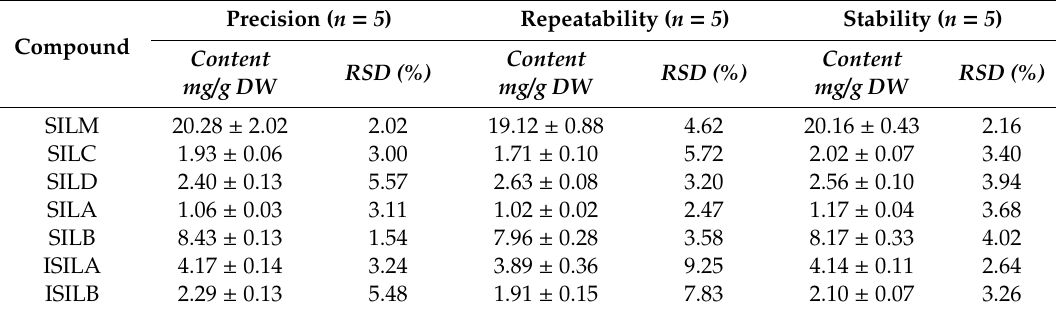
Table 5. Precision, repeatability and stability validation parameters of the